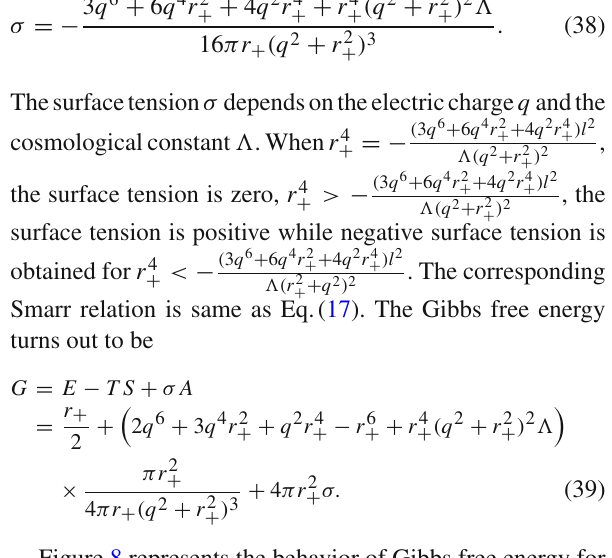
Figure 8 represents the behavior of Gibbs free energy for the different values of surface tension, three cases will be discussed, i.e. the surface tension is positive, negative and zero. When the temperature is low, Gibbs free energy